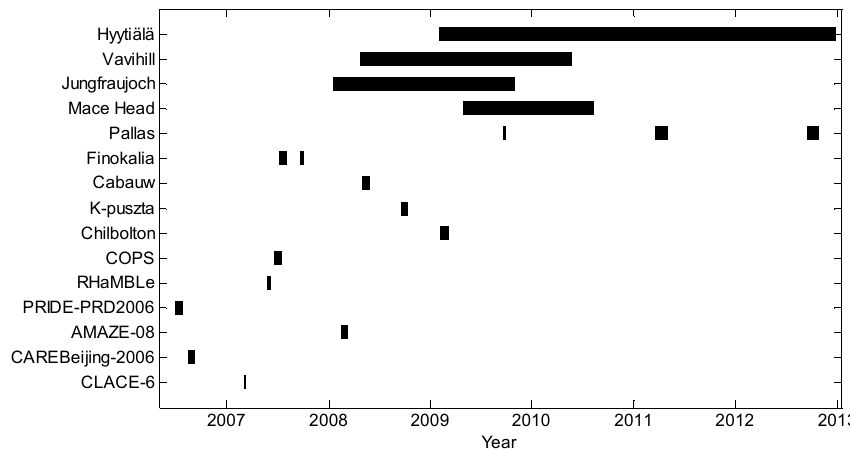
Figure 2. Periods of available data for all locations and campaigns.